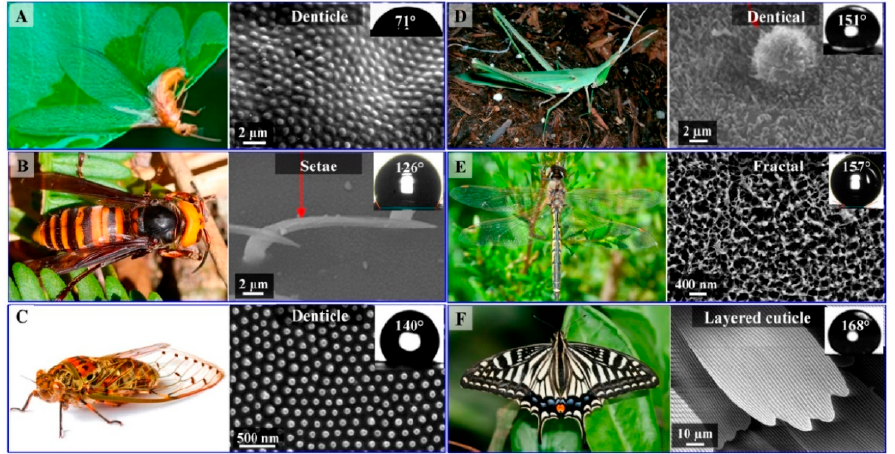
Figure 17. Insects and electron microscopy images (TEM and SEM) of their wings with their respec- tive water contact angle of water droplets on the wing surface. ( A ) Isoptera schedorhinotermes sp.; ( B ) Hymenoptera vespa sp.; ( C ) Hemiptera meimuna microdon; ( D ) Orthoptera Acrida cinerea; ( E ) Odonata hemicordulia tau, and ( F ) Lepidoptera Papilio Xuthus [259]. ( B – E ) © Encyclopedia of Life; ( F ) © Stepanka Nemcova and Anne Ten Donkelaar. Micrographs ( B ) and ( D ) adapted with permission from [259,260]; © Elsevier, 2009. Image A and micrograph C adapted with permission from [261]; © PLoS, 2011. In birds, the complex colorful feather patches and various traits are used to attract partners as protection against predators or to recognize other birds of the same species [262]. Feather colors result from light absorption by pigments and/or a coherent light scat- tering of nanostructures of the feather components (keratin, melanin, and air), altering the RI of which varies periodically. Structural colors generate by the nanostructure produced by melanosomes. They are organelles with melanin that form thermodynamically stable, ordered structures. The increment of RI contrast or the relative amount of material with low RI (e.g., keratin) results in brighter or more saturated colors. For this process, the space between melanosomes increments, thus potentially reducing the order and consequently the thermodynamic stability [262]. In many birds, feathers with non-iridescent structural colors are a crucial part of their appearance (Figure 18). These colors generate by three- dimensional, amorphous (or quasi-ordered) spongy nanostructures made of β -keratin and air within the feather barb medullary cells.